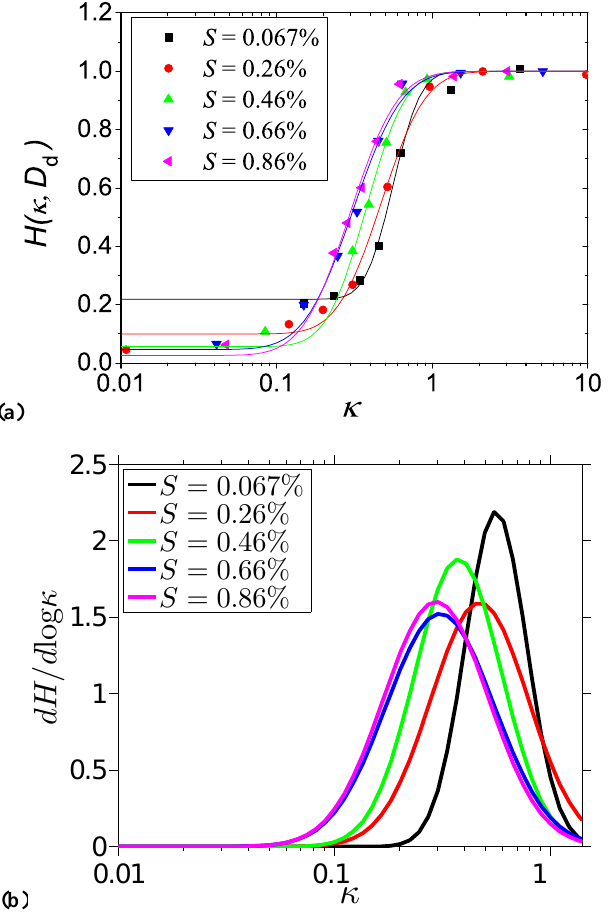
Fig. 8. Average cumulative particle hygroscopicity distributions, H(κ,D d ) (a) corresponding to the CCN efficiency spectra (Fig. 7) observed in the CAREBeijing-2006 campaign. The color lines in (a) are the fitted curves in the form of Eq. (34) to the correspond- ing measurement data points (of the same color). The logarithmic probability distributions, dH(κ,D d )/d log κ in (b) were calculated from the fitted curves shown in